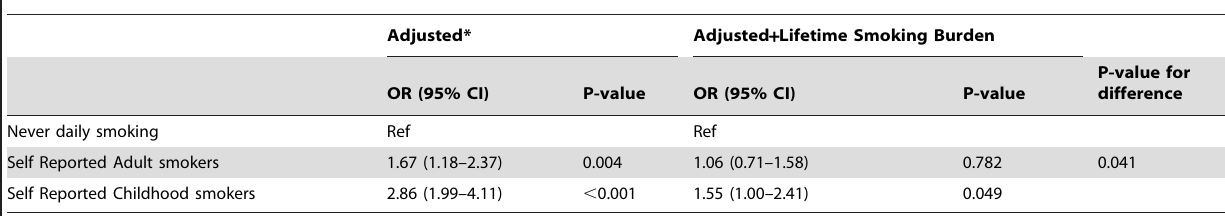
Table 2. Risk of peripheral arterial disease by age of daily smoking